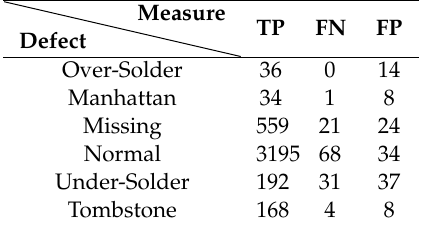
Table A2. Classification results of early-merge dual-stream CNN.